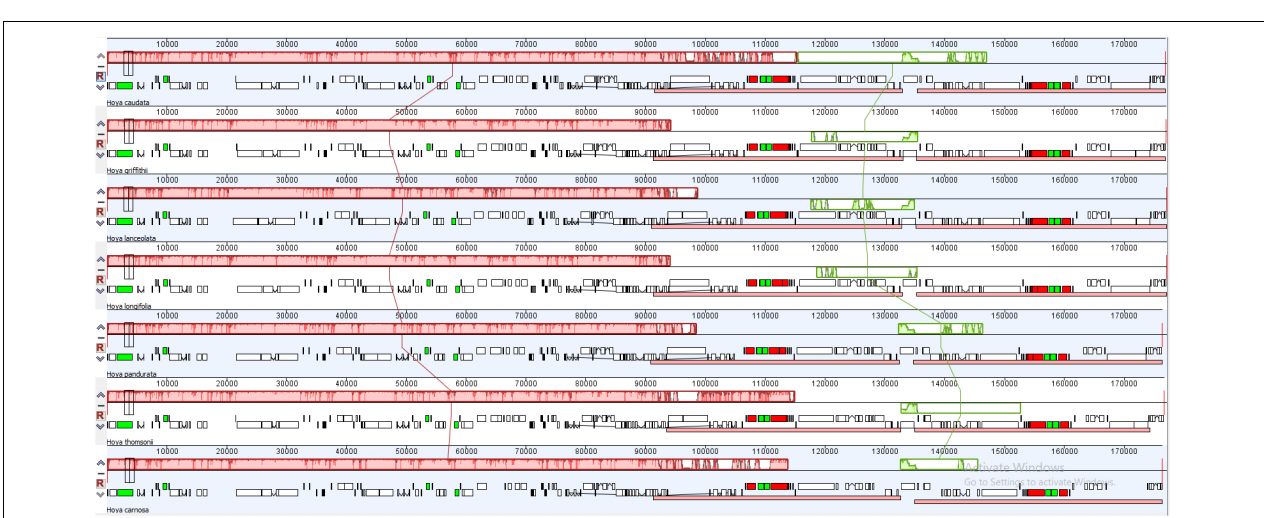
FIGURE 2 | Rearrangements in 7 Hoya plastomes using the mauve multiple alignment algorithm. Different colors represent different collinear blocks. The lines linking the collinear blocks represent homology between different genomes. The scale above each genome indicates nucleotide positions, and the white regions